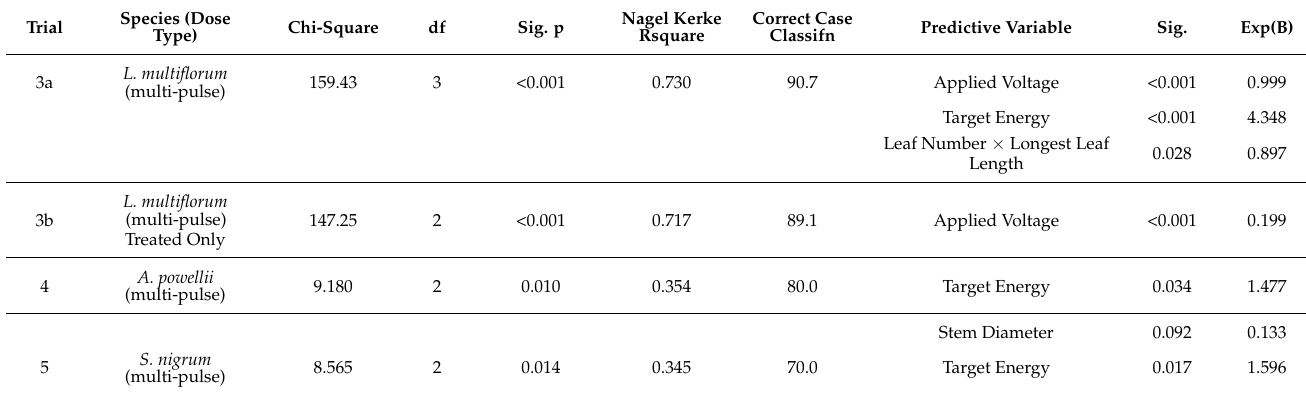
Table 6. Statistical summary table of binary logistic regression analyses of factors significantly predicting the probability of weeds dying after receiving multiple pulse electric treatments.